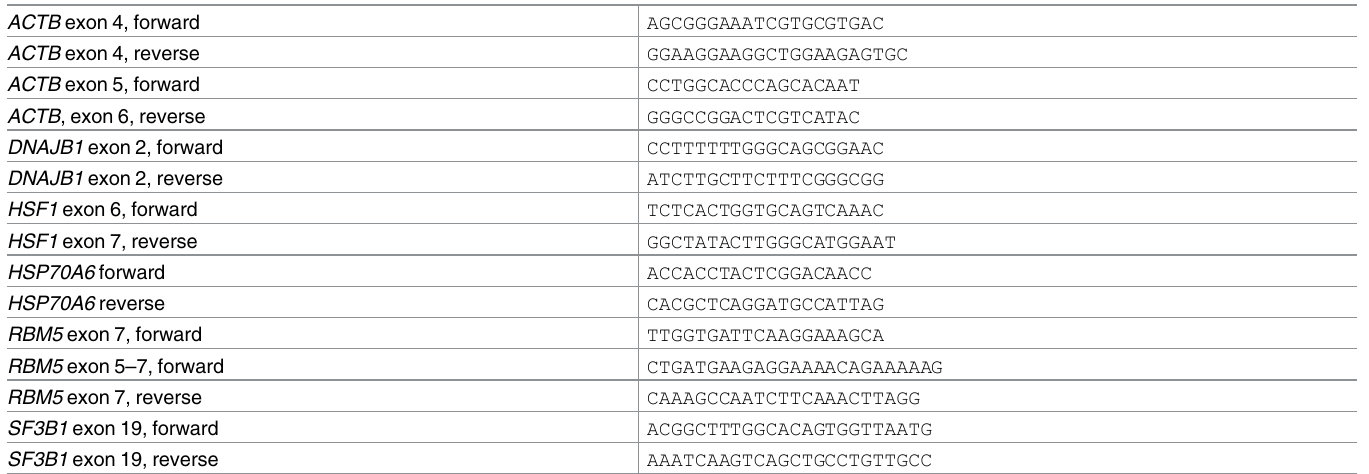
Table 1. List of oligonucleotide